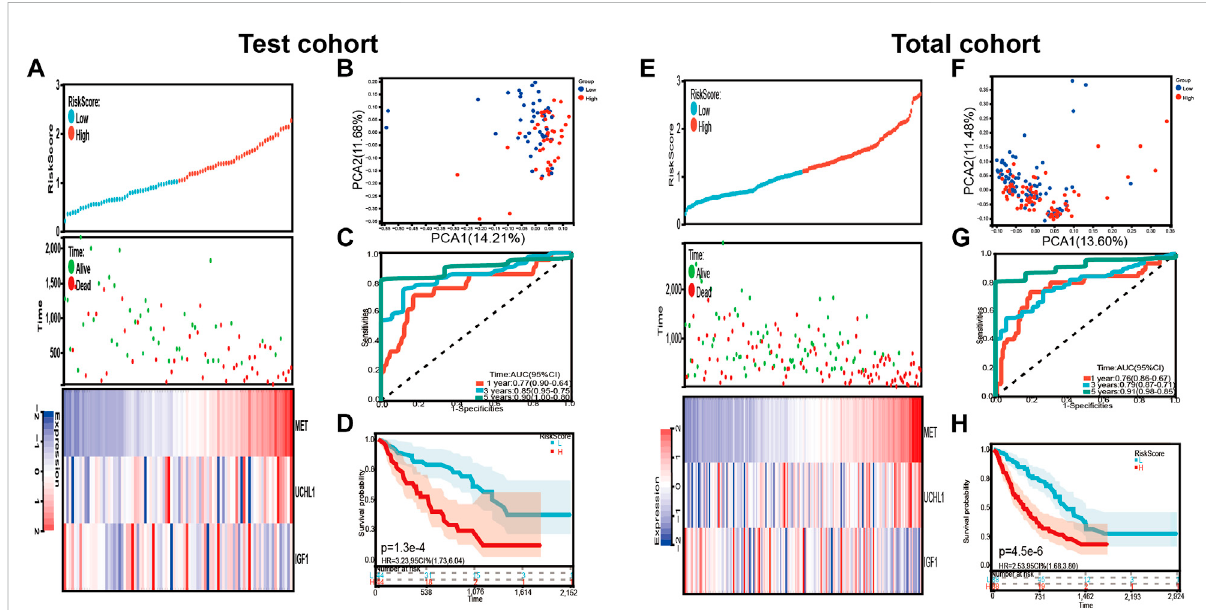
FIGURE 5 Validationoftherisksignatureinthetestcohortandtotalcohort. (A,E) thedistributionofriskscore,survivalstatus,andexpressionlevelsofthree differentiallyexpressedprognosticgenesrelatedtoCOVID-19intestcohortandtotalcohort. (B,F) ThePCAplotoftestcohortandtotalcohort (C,G) Time-dependent ROC analysis of our risk signature in test cohort and total cohort. (D,H) The overall survival of IPF patients in test cohort and total cohort.